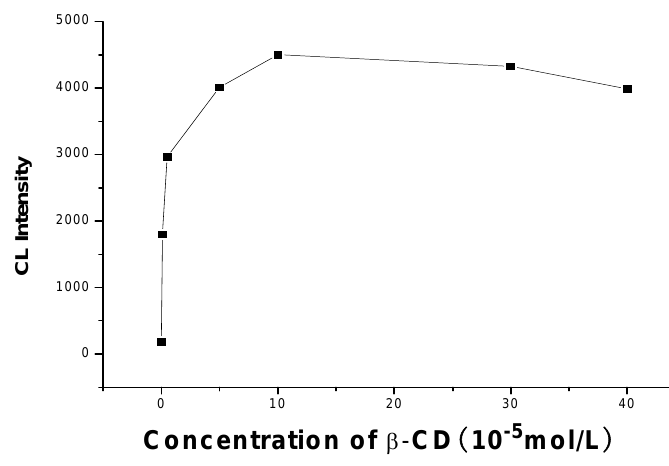
Figure 4. Effect of β -CD concentration on CL intensity (sample = 6 ng/mL).